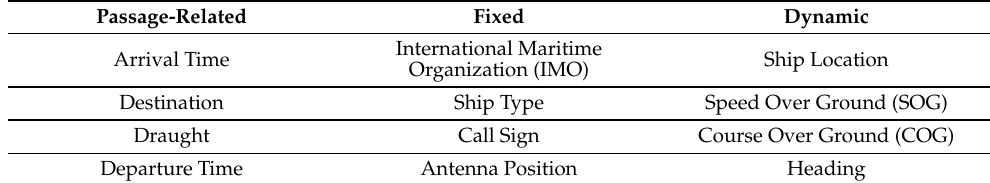
Table 2. Types of information in the AIS